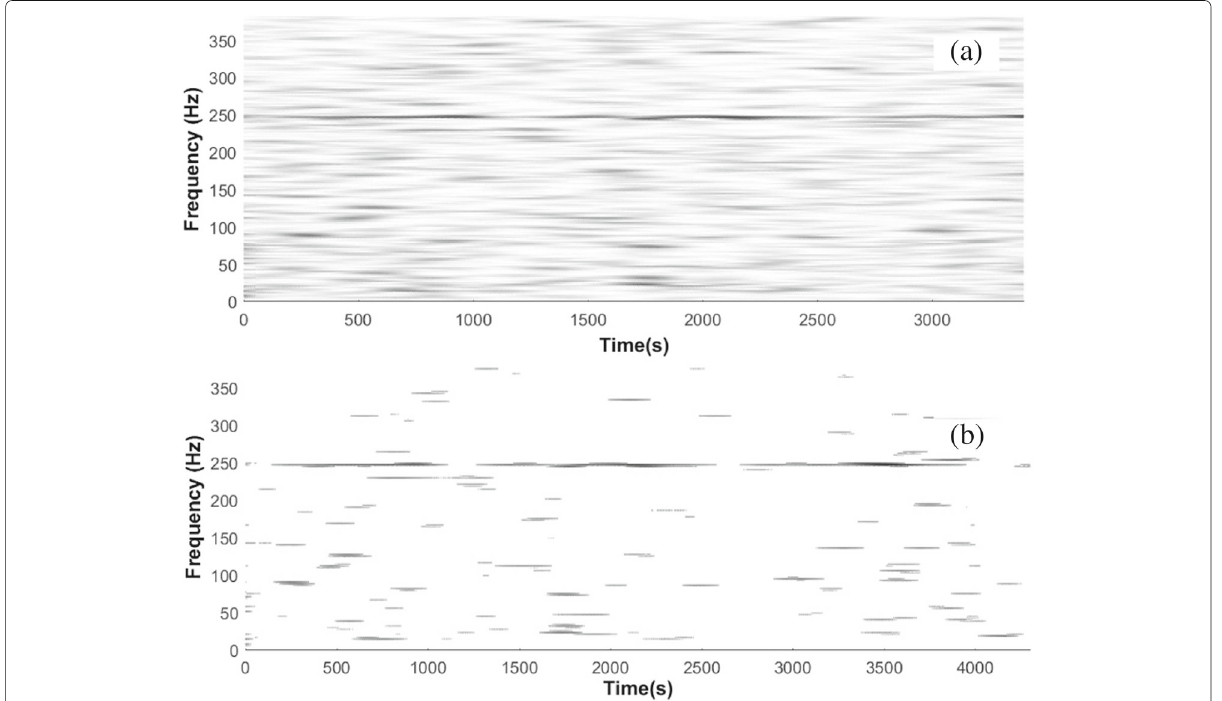
Fig. 4 a Measured valid electrode spectrogram and b spectrogram after applied K-means denoising